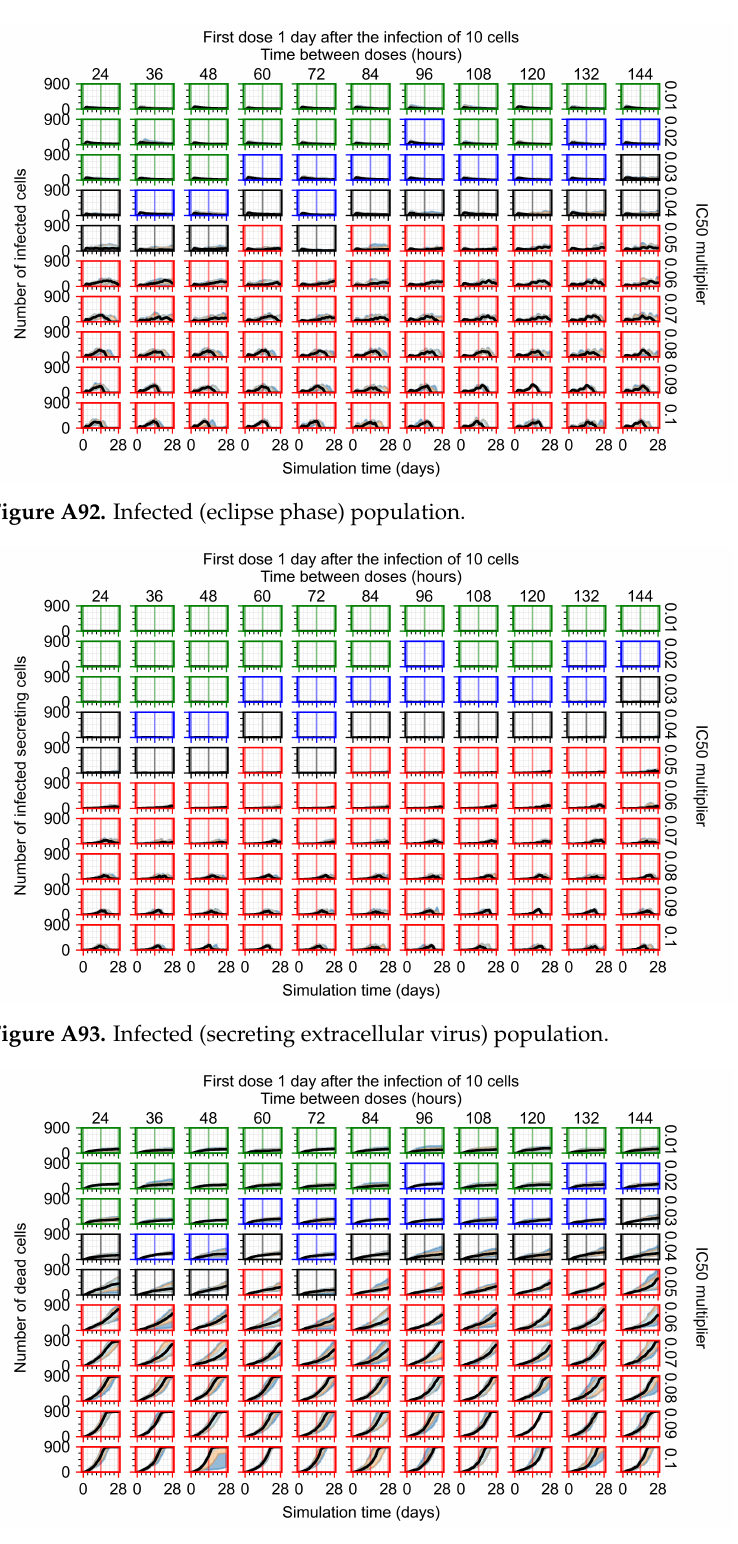
Figure A94. Dead